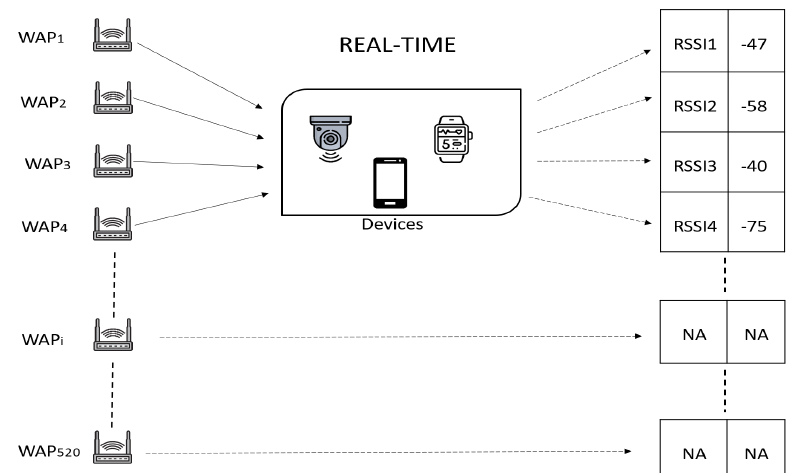
Figure 3. Sparsity in RSSI